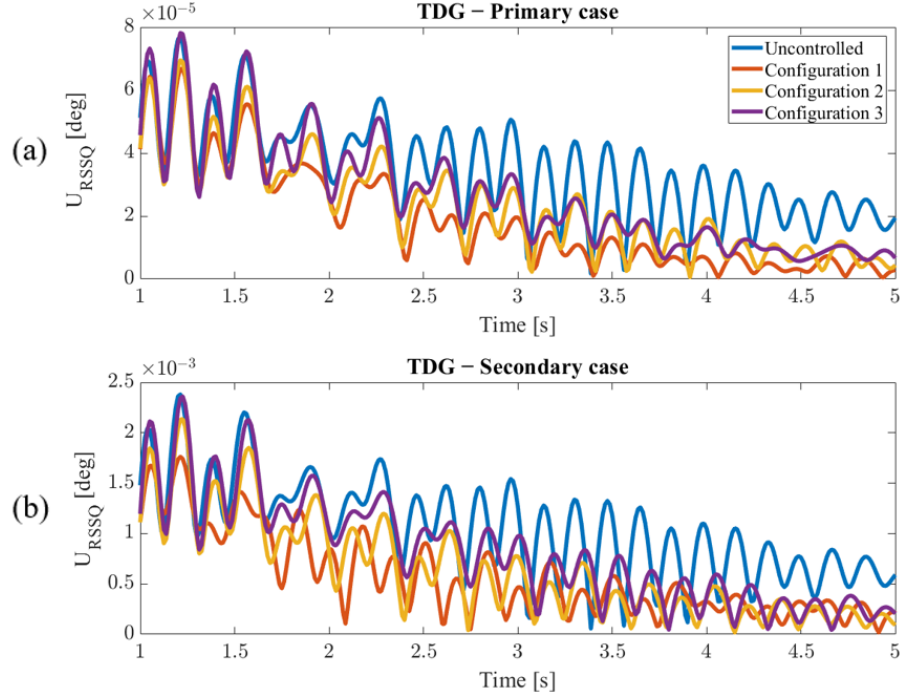
Figure 13. Comparison of Pareto fronts between all configurations investigated in the study for both the ( a ) primary and ( b ) secondary operational scenarios modelled with the TDG. Table 5. Pareto front values for the best individuals under the TDG gust excitation model.